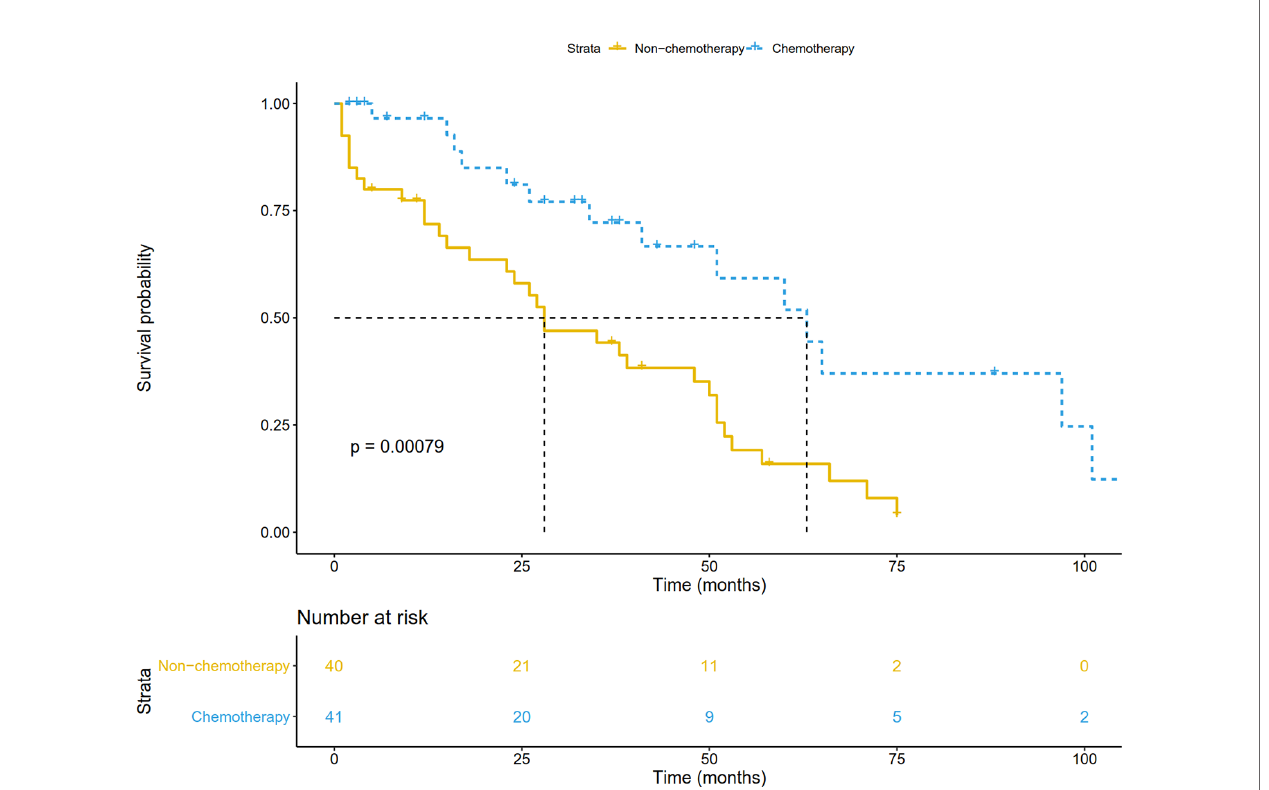
FIGURE 8 | Disease-free survival comparison by treatment arm for stage IB NSCLC patients in the validation